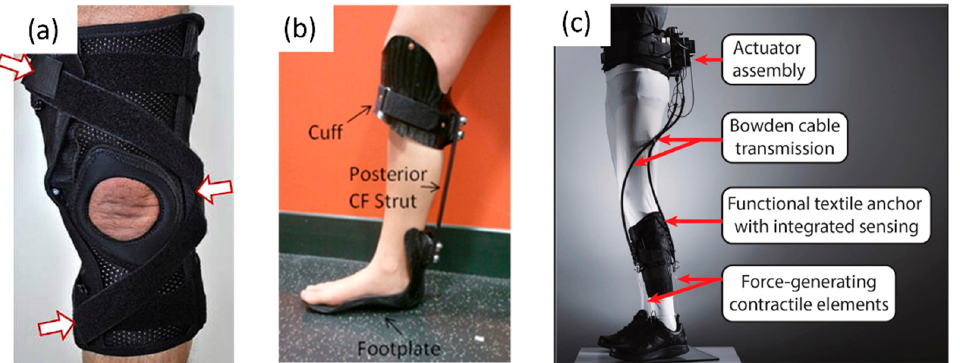
Figure 3. Examples of lower-limb exosuit devices: ( a ) Passive knee sleeve with pneumatic chambers (reproduced from [26]), ( b ) passive elastic ankle brace (reproduced from [27]), ( c ) active ankle assistive exosuit (reproduced from [28]).